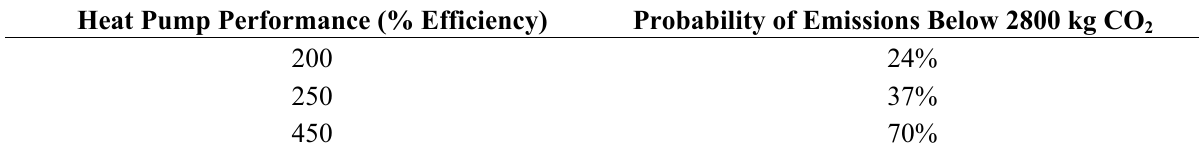
Table 6. Emissions probability for a given emissions